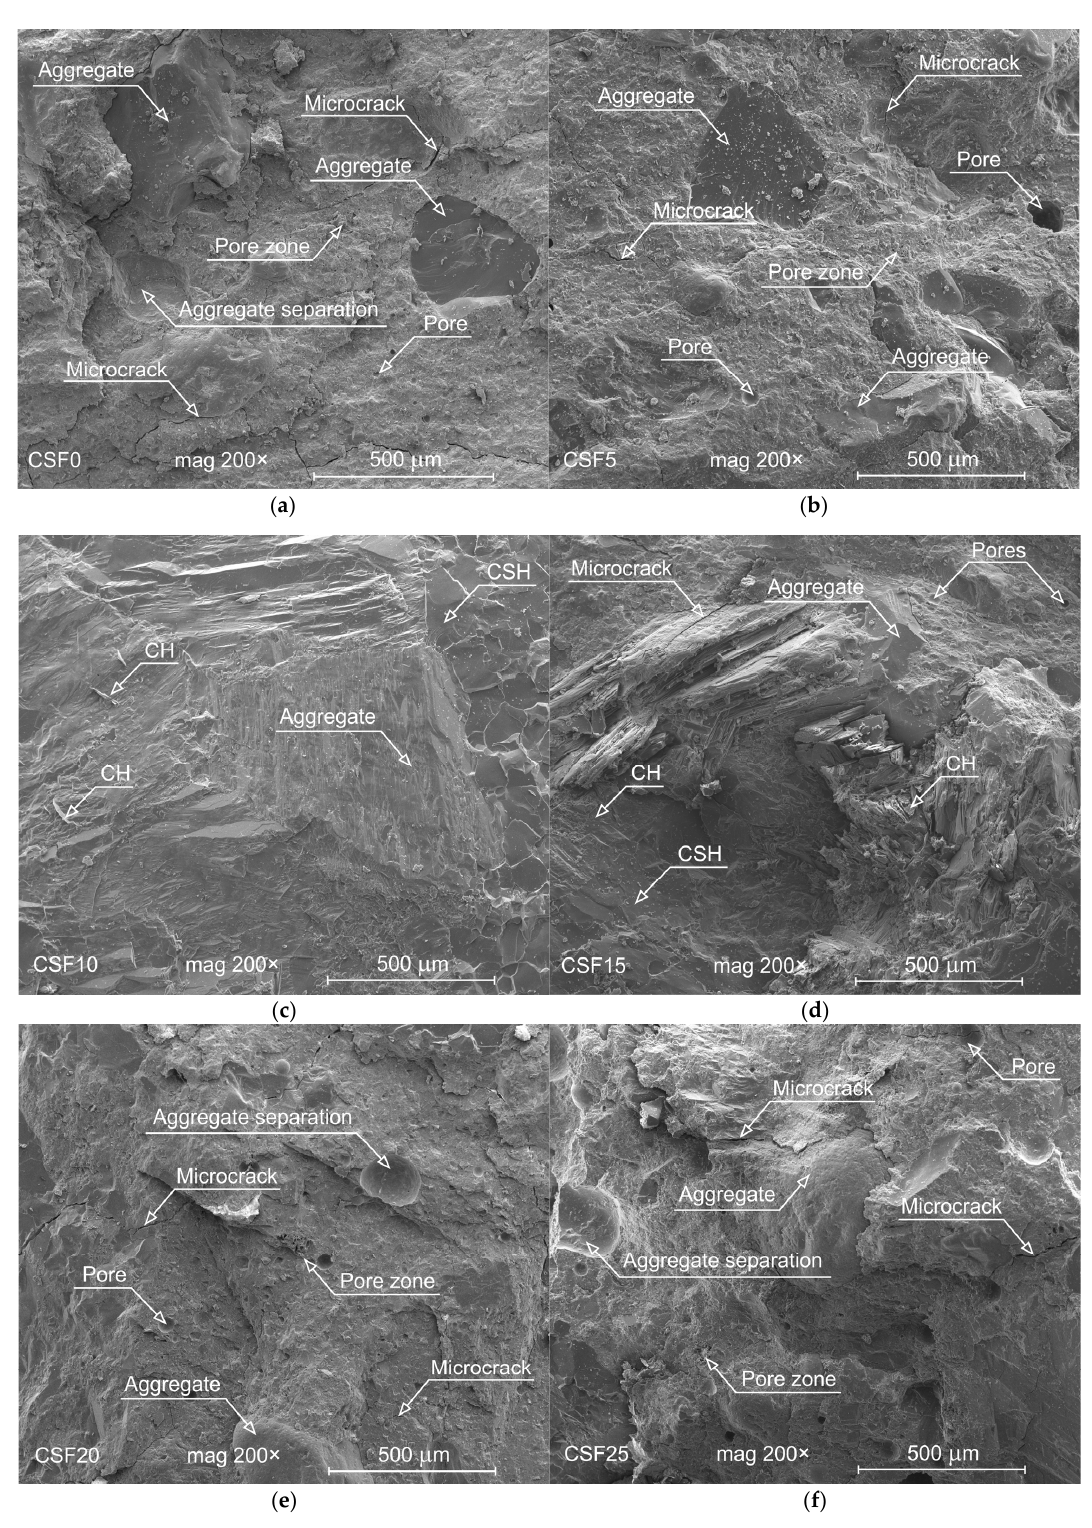
Figure 12. SEM microphotographs in 200× magnification for HPC with CSF content of ( a ) 0%; ( b )